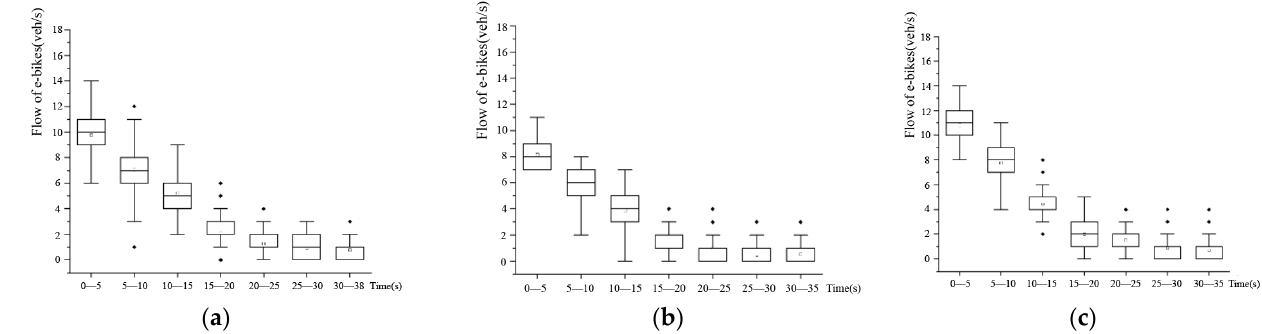
Figure 3. Straight flow profile of entrance road: ( a ) Longpan Road and Bancang Street intersection of the northwest entrance road; ( b ) Longpan Road and Bancang Street intersection of the southwest entrance road; ( c ) Shanghai Road and Huaqiao Road intersection of the southwest entrance road.